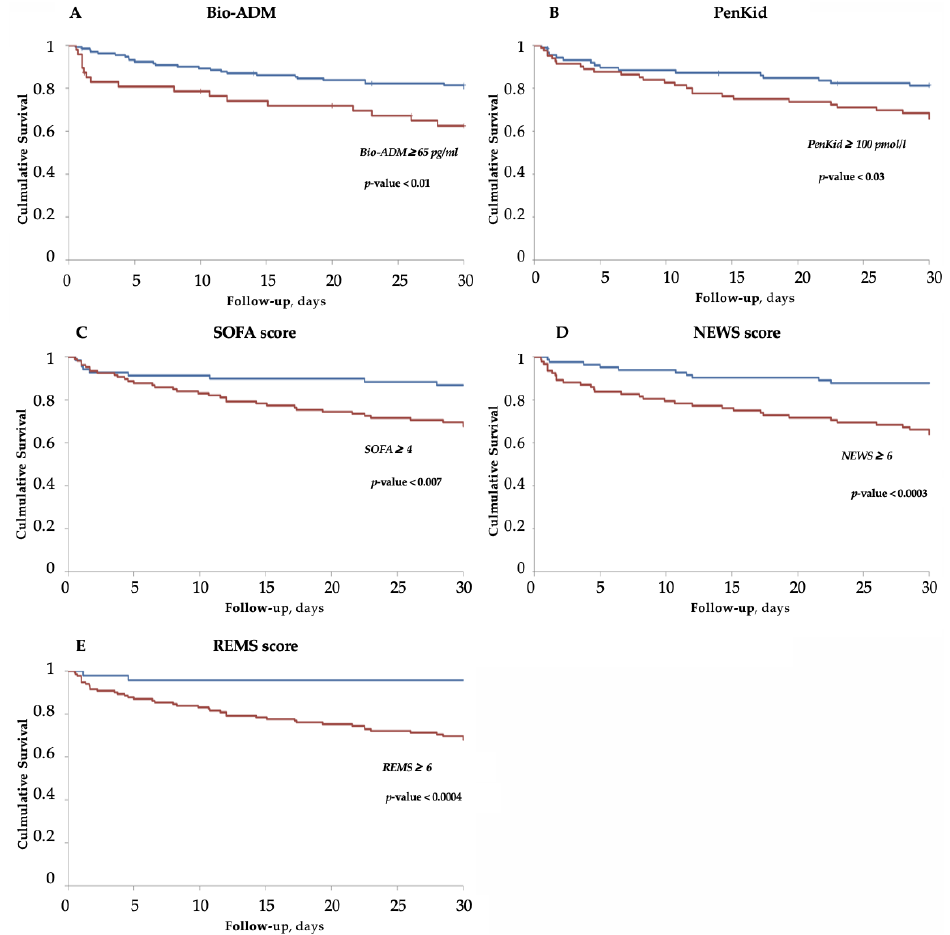
Figure 2. Kaplan–Meier curves according to survival at 30 days for Bio-ADM ( A ), PenKid ( B ), SOFA( C ), NEWS ( D ) and REMS score ( E ). ( A ) For Bio-ADM, we considered a cut-off of 65 pg/mL. The red curve represents patients with Bio-ADM > 65 pg/mL, the blue curve patients with Bio-ADM < 65 pg/mL; ( B ) for PenKid, we considered a cut-off of 100 pmol/L. The red curve represents patients with PenKid > 100 pmol/L, the blue curve patients with PenKid < 100 pmol/L; ( C ) for SOFA score, we considered a cut-off of 4: the red curve represents patients with SOFA > 4, and the blue curve patients with SOFA < 4; ( D ) for NEWS score we used a cut-off of 6, the blue curve represents patients with NEWS < 6. ( E ) For REMS score we considered a cut-off of 6 points. The dashed curve represents patients with REMS > 6, and the solid curve patients with REMS < 6.